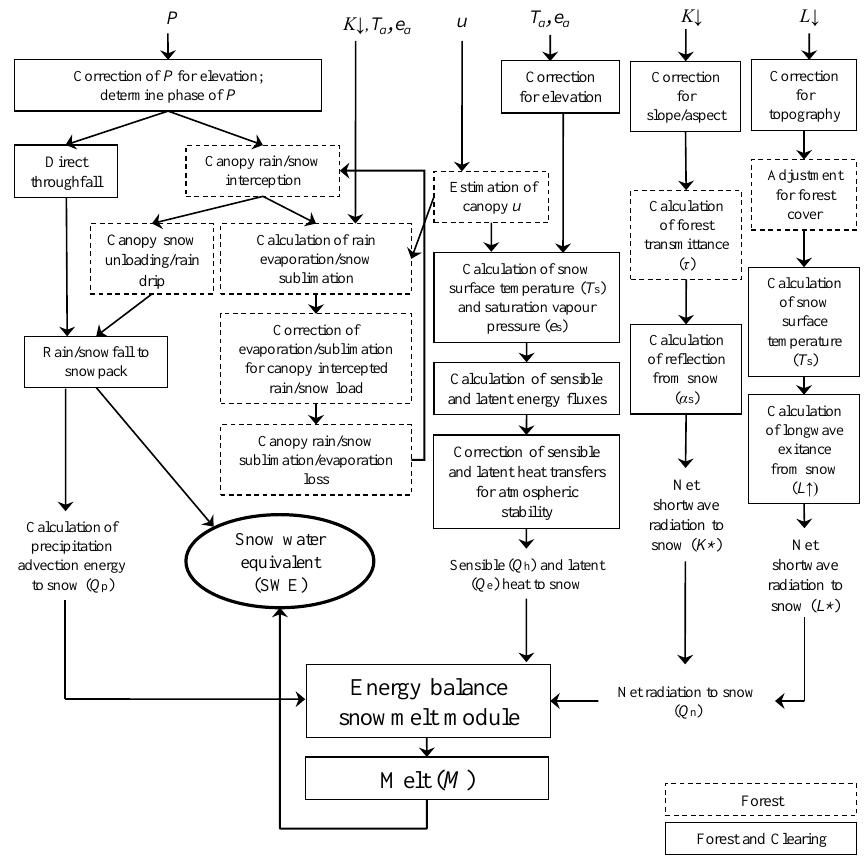
Fig. 1. Schematic outlining the major mass and energy calculations involved in the forest component of the Cold Regions Hydrological Model